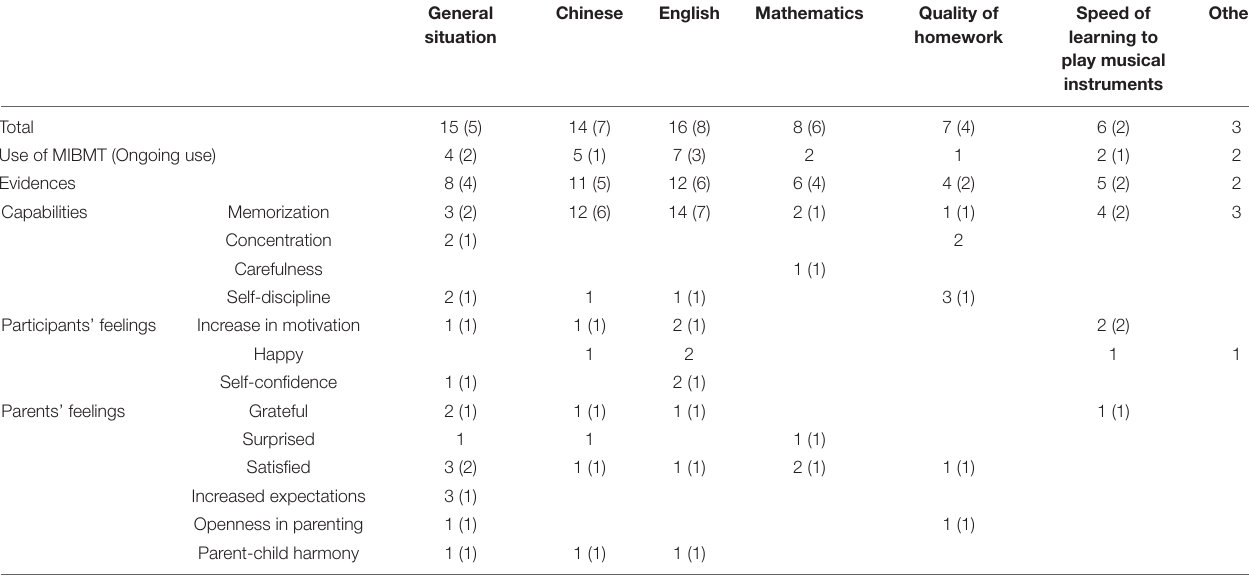
TABLE 17 | Theme 1: positive feedbacks after training in Experiment 2: achievements (the numbers in parentheses represent high-use groups).